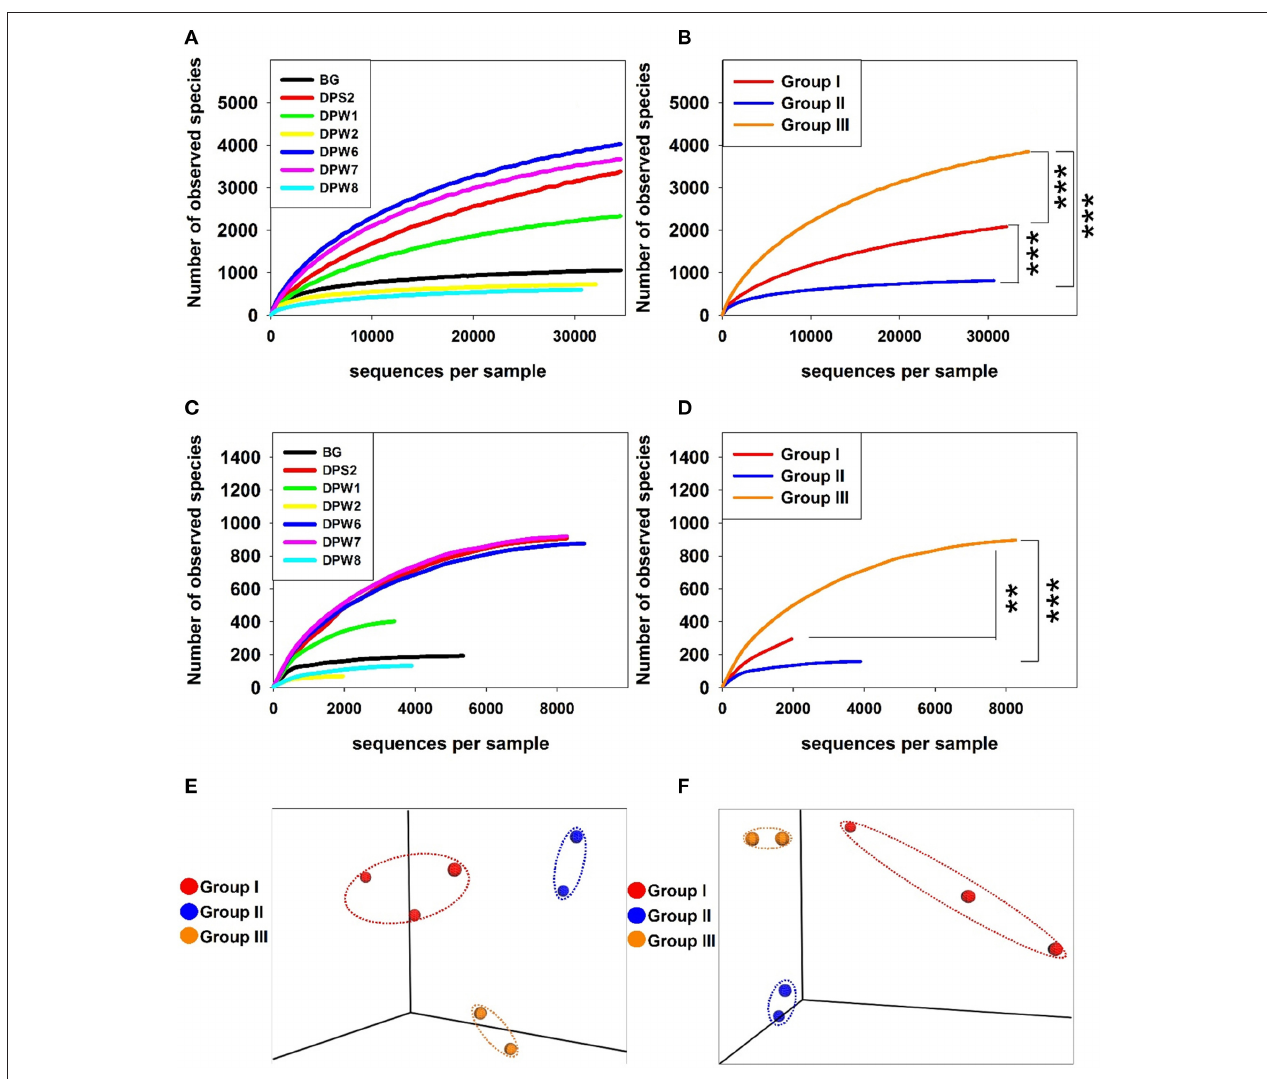
FIGURE 2 | Rarefaction plots of the bacterial (A,B) and archaeal (C,D) communities in groundwater samples. Three-dimensional principle coordinate analysis (PCoA) plots based on UPGMA (Unweighted Pair Group Method with Arithmetic Mean) data (E,F) . Rarefaction curves display the number of operational taxonomic units defined with 97% detected based on the sampling intensity of the libraries. Rarefaction curves of bacteria display the number of observed species obtained from individual samples with increasing sequencing effort (A) and compare the average values obtained from the sample included in each group (B) . Rarefaction curves of archaea display the number of observed species obtained from individual samples (C) and compare the average values obtained from the sample included in each group (D) . Mann-Whitney rank sum test were used to identify statistically significant differences between two groups (*** p < 0.001 and ** p < 0.01). PCoA plots were generated from the weighted UniFrac analysis of the bacterial (E) archaeal (F)